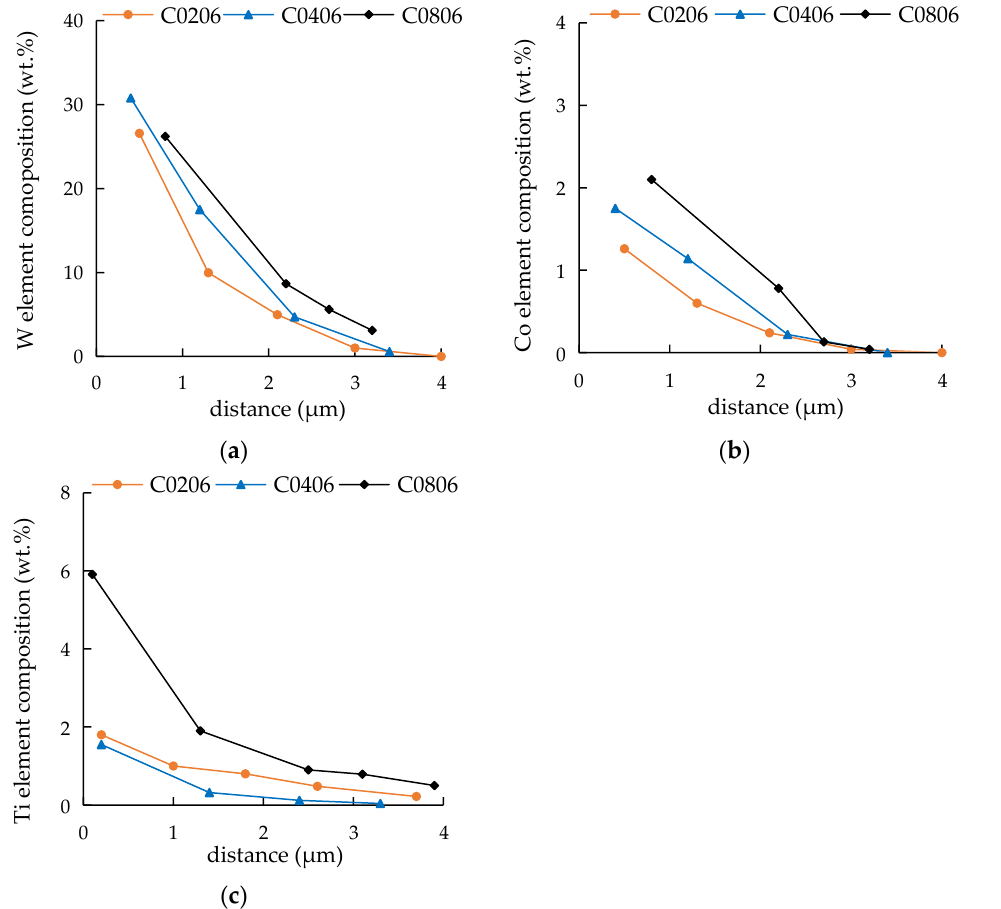
Figure 7. Diffusion between the cemented carbide samples with different WC grain sizes and the Ti6Al4V. ( a ) Diffusion of the W element; ( b ) Diffusion of the Co element; ( c ) Diffusion of the Ti element.